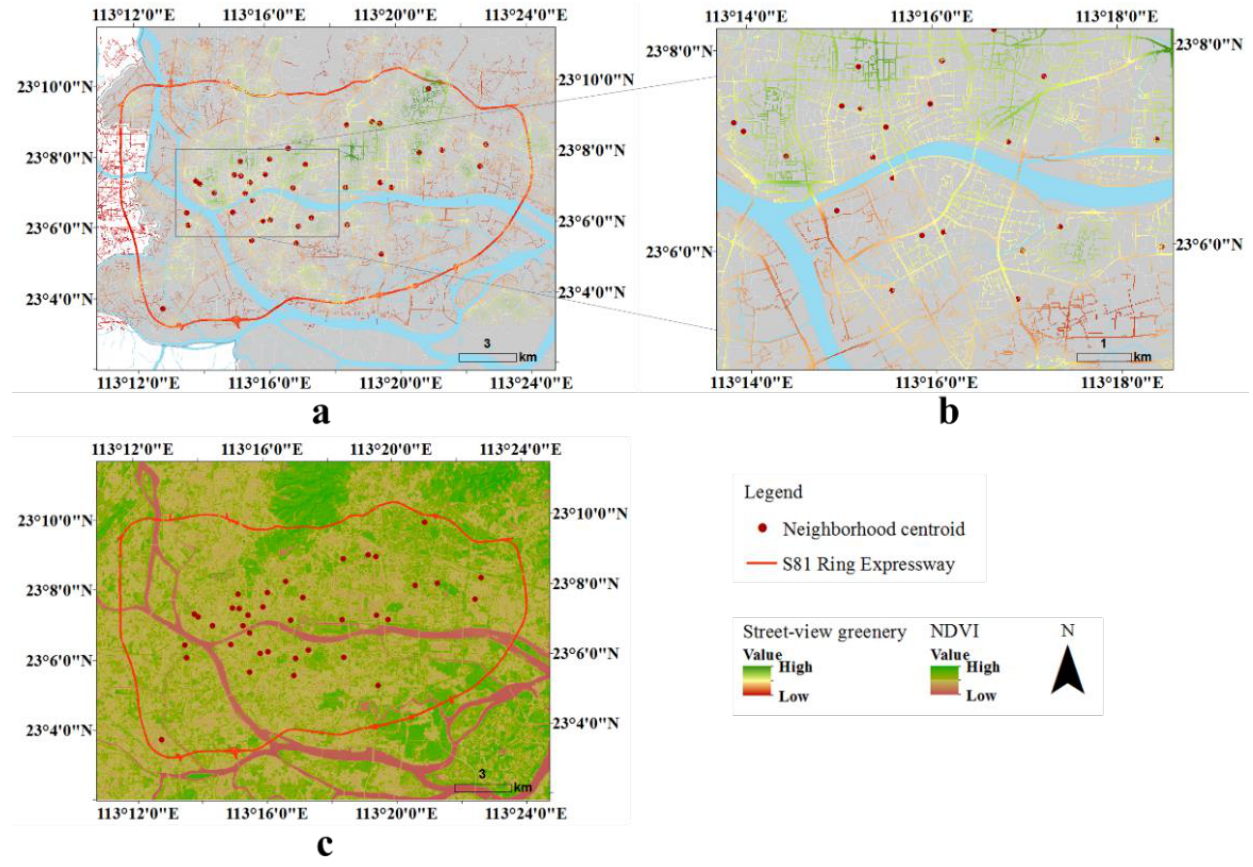
Figure 5. Visualization of green space in central Guangzhou ( a ) greenery derived by the street-view imagery; ( b ) a zoomed-in view; ( c ) NDVI derived by satellite imagery on 7 February 2016).